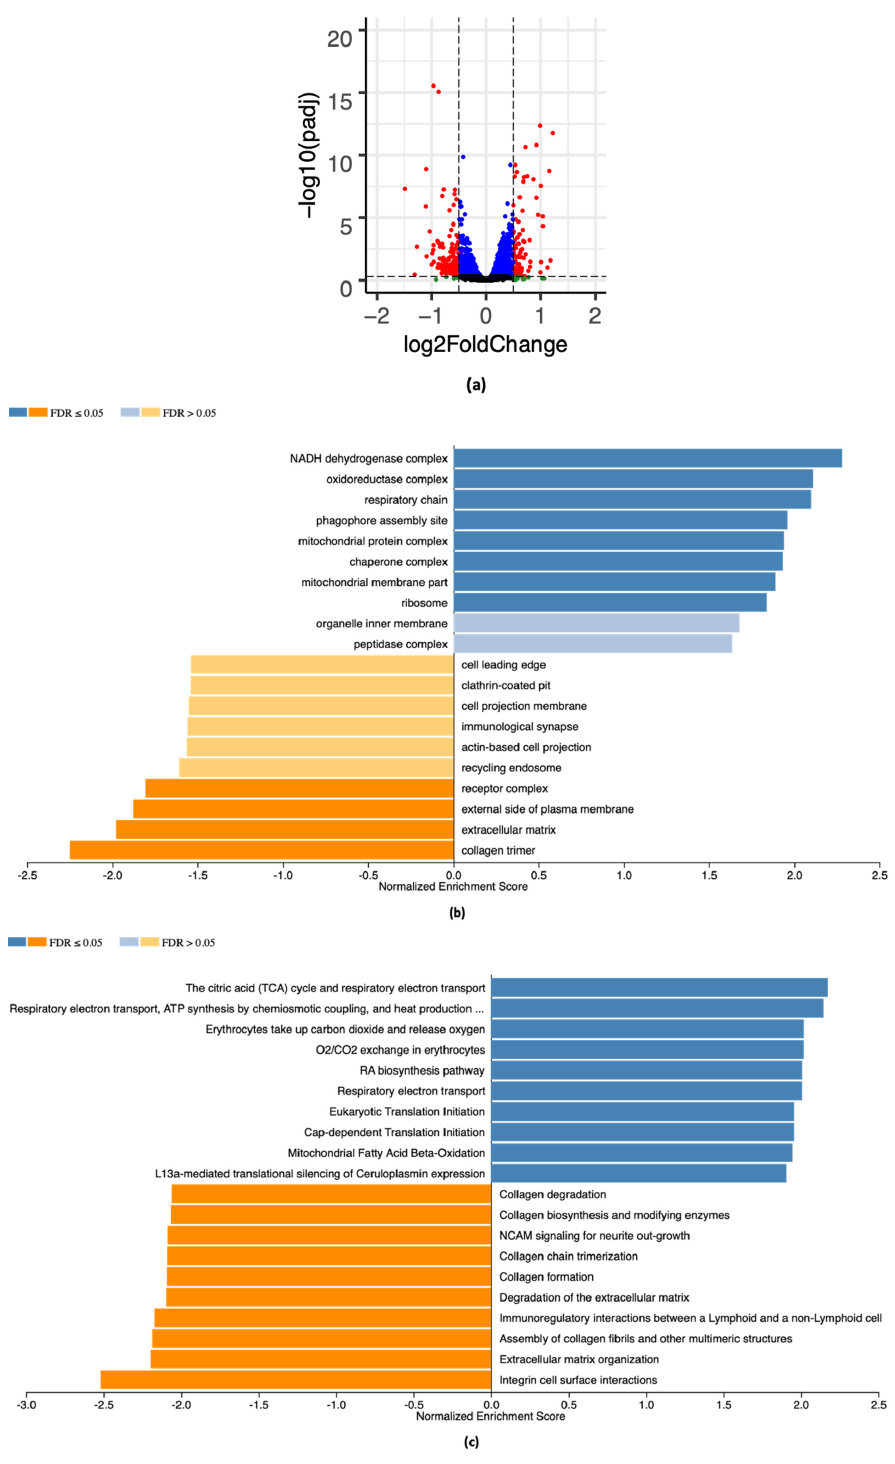
Figure 4. RNA-seq analysis comparing the transcriptome of α 1 r/r α 2 s/s and α 1 s/s α 2 s/s hearts: ( a ) Volcano plot of gene expression in α 1 r/r α 2 s/s and α 1 s/s α 2 s/s hearts plotting -log10 of adjusted p -value on y-axis and log2 fold change on x-axis. Red dots are downregulated (left) and upregulated (right) genes with a log2 fold change greater than 0.5. Blue dots represent those genes with a log2 fold change less than 0.5. Green and black dots represent genes with an adjusted p -value greater than 0.05. ( b ) The enriched pathways in the category of Cellular Component of the Gene Ontology database. ( c ) Pathway enrichment using the Reactome database. Pathway enrichment analysis were performed with Gene Set Enrichment Analysis (GSEA) as described in the Materials and Methods section. Blue bars represent upregulated pathways and orange bars represent downregulated pathways.